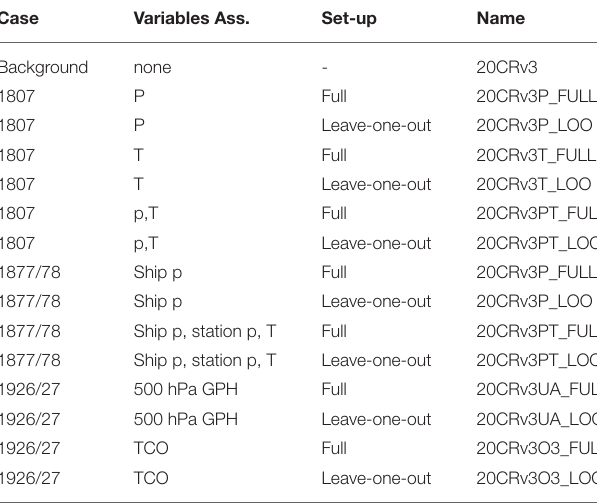
TABLE 4 | Assimilation experiments performed in this